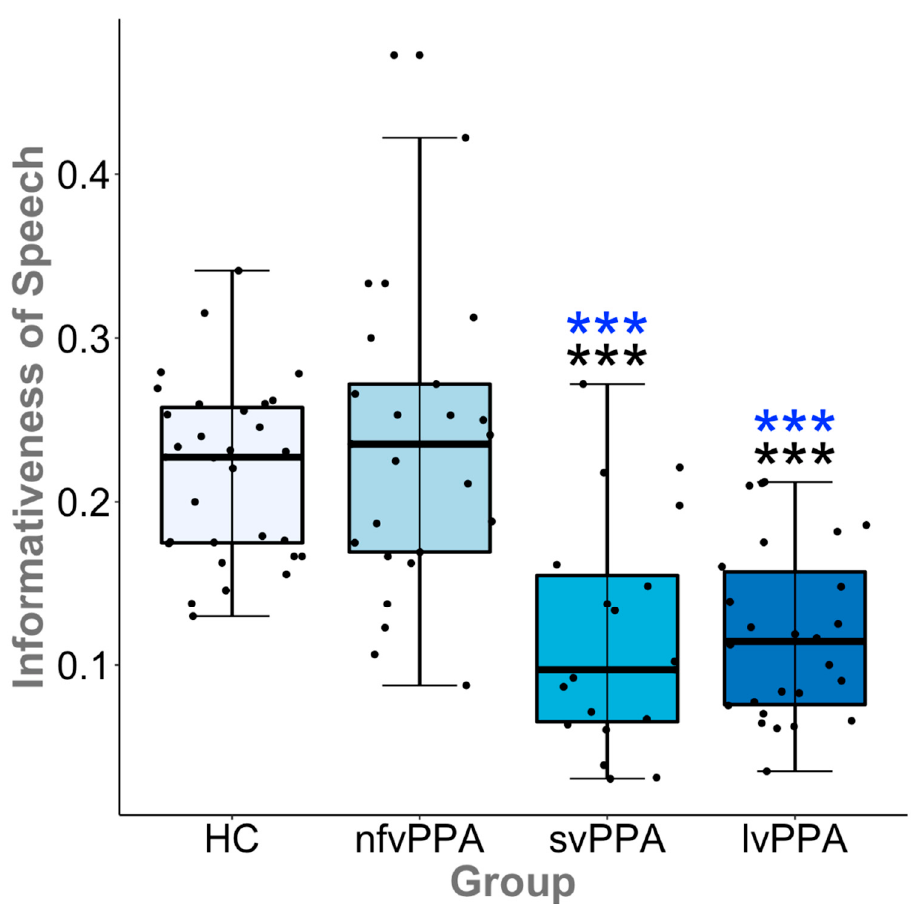
Figure 3. Illustrated here with the CU-uniqueref results, both the logopenic variant primary progressive aphasia (lvPPA) and semantic variant (svPPA) exhibited reduced informativeness of speech relative to controls, whereas the non-fluent/agrammatic variant (nfvPPA) group did not. The informativeness of speech output by the nfvPPA group was greater than that of lvPPA and svPPA. The error bars represent the 95% confidence interval of the median for each group. Significant differences are represented by asterisks (HC, black; nfvPPA, blue; *** p < 0.001).